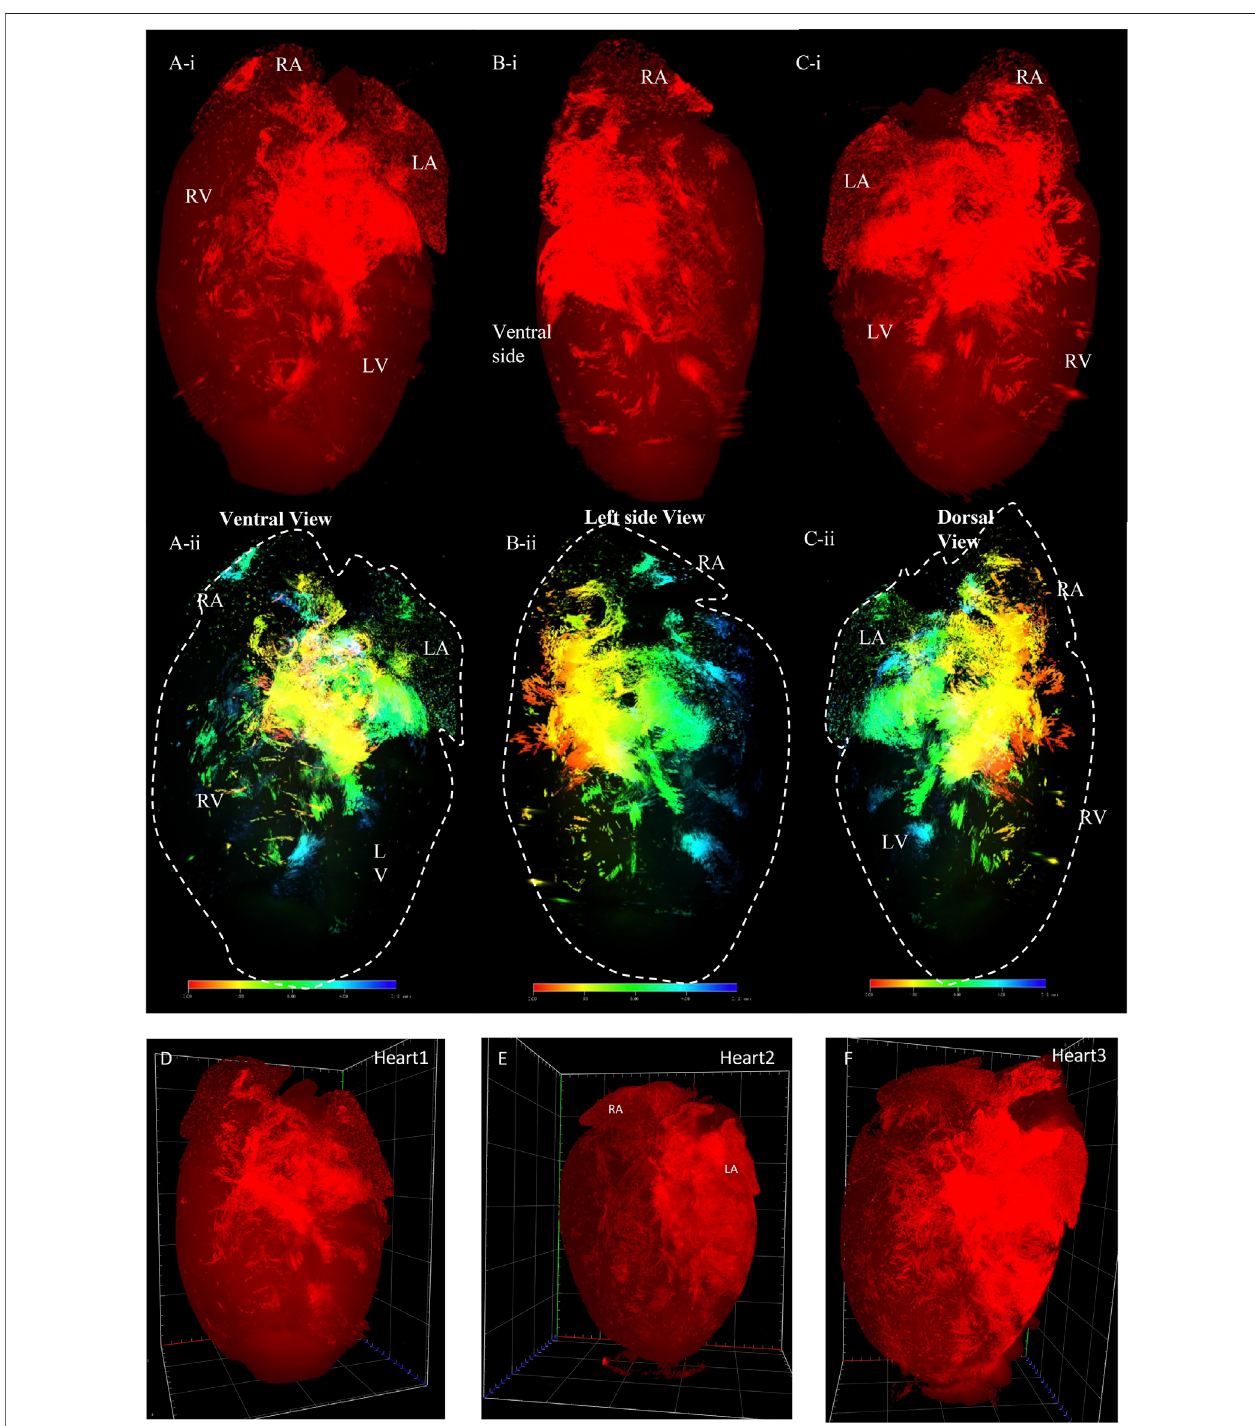
FIGURE 4 | 3D volume reconstruction of the spatial distribution of Pnmt + cell-derived cardiomyocytes (PdCMs) in adult Pnmt Cre/ChR2 − tdTomato heart. (Ai – Ci) The tdTomato fl uorescence images show the distribution of PdCMs from the ventral, left side, and dorsal view respectively (also see online video 3, heart size: 7.86 mm × 11.26 mm x 6.113 mm). (Aii – Cii) The depth code image showing the distribution of PdCMs from the ventral, left side, and dorsal view respectively, corresponding to (Ai − Ci) (also see online video 4). (D – F) Three representatives oftdTomato fl uorescence image showing the consistent signal pattern in adult Pnmt Cre/ChR2 − tdTomato mouse hearts. (n number = 3). LA: left atrium; RA: right atrium. LV: left ventricular; RV: right ventricular.